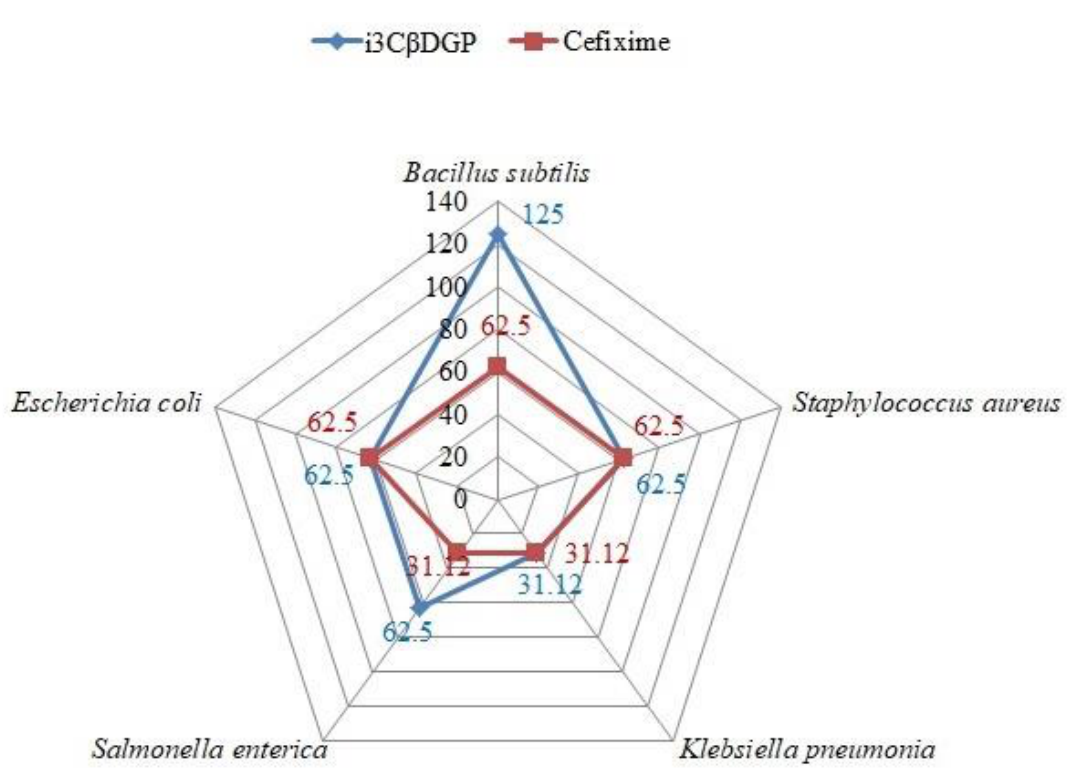
Figure 4. Comparison between MIC values ( µ g/mL) of iriflophenone-3-C- β -D-glucopyranoside (i3C β DGP) and Cefixime (well-known antibiotic) against various bacterial pathogens of human GIT.